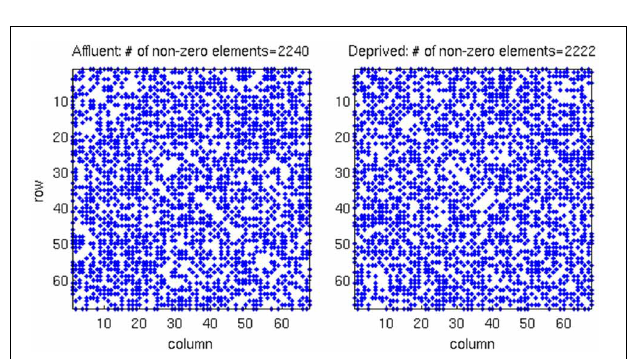
FIGURE 5 | The raw correlation matrix for each group shows that two groups have almost equal number of non-zero components in the matrix. The correlation matrix for each group is given by a 68 × 68 matrix, where each value in the matrix is calculated from the cortical thickness correlation measured in 21 individuals. Affluent: Least deprived; Deprived: Most